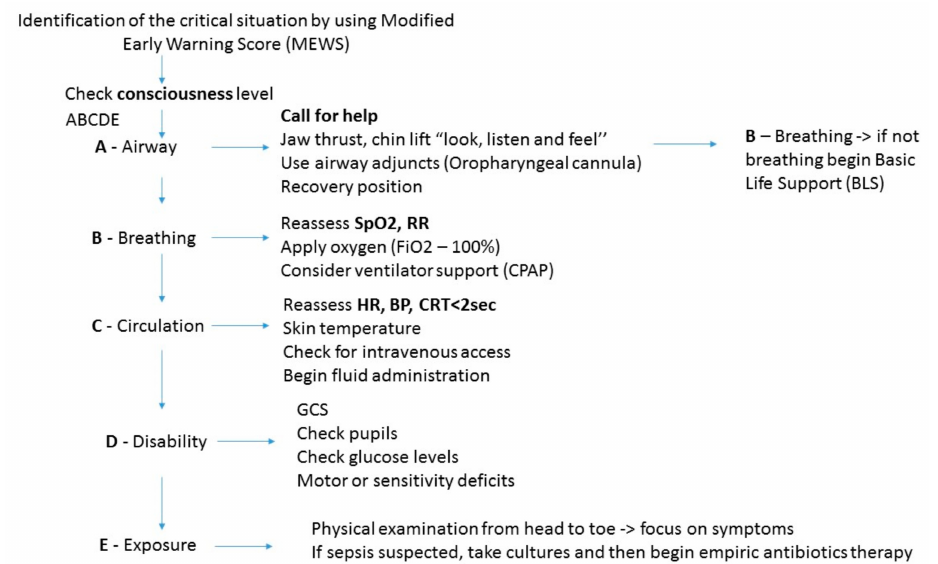
Figure 1. ABCDE (Airway, Breathing, Circulation, Disability, Exposure) steps. SpO 2 —peripheral oxygen saturation; RR—respiratory rate; CPAP—continuous positive airway pressure; HR—heart rate; BP—blood pressure; CRT—capillary refill time; GCS—Glasgow Coma Scale.